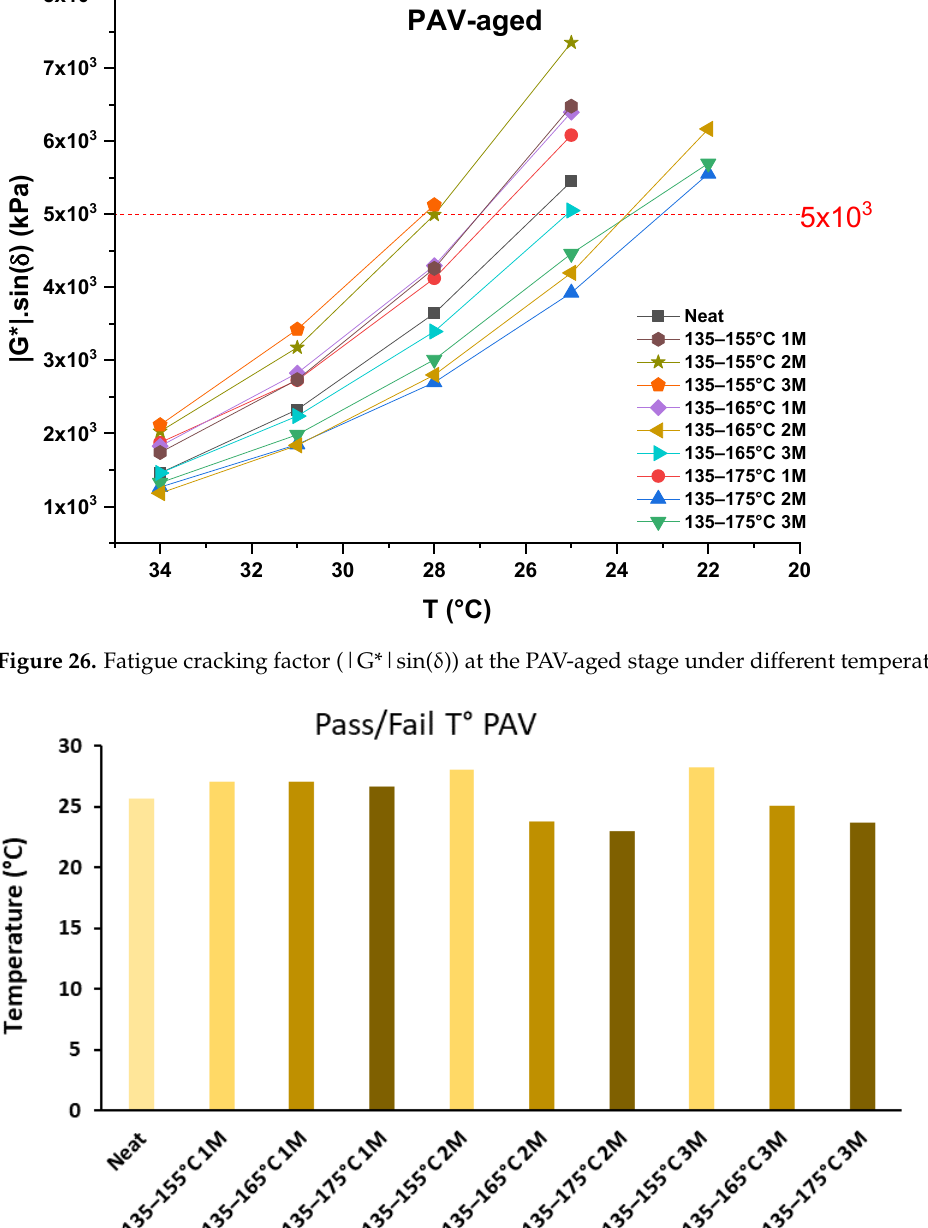
Figure 27. Pass/fail temperatures of all samples at the PAV-aged stage.